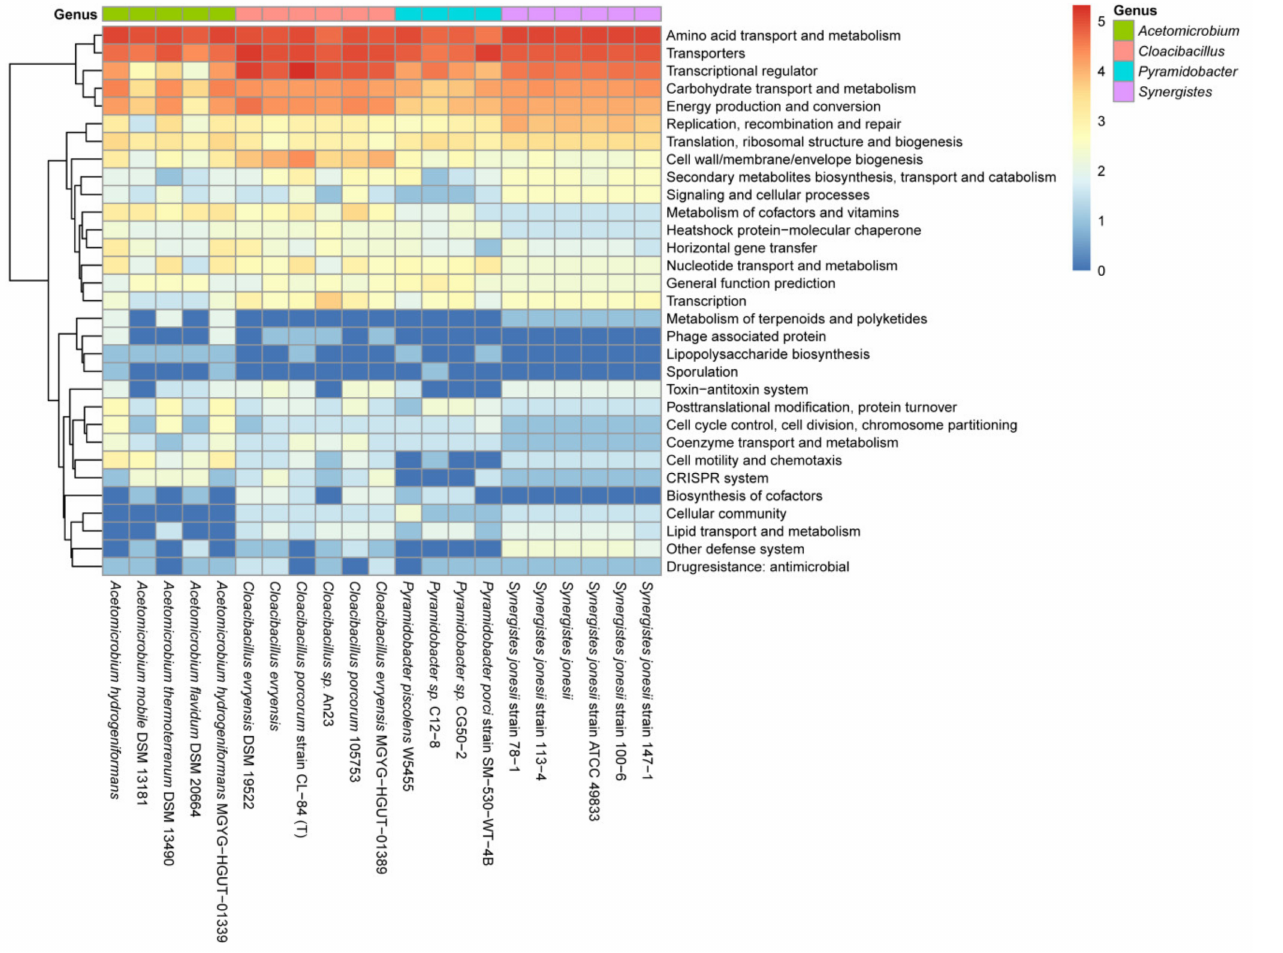
Figure 6. A pathway-enrichment heat map showing the clustering of loci regulated by the CodY-like protein. The positions of the four genera are color-coded and listed on the top of the figure. The number of loci regulated by the CodY-like protein was analyzed based on the predicted function. The number was converted using log 2 (N + 1), where the N is the number of the identified target